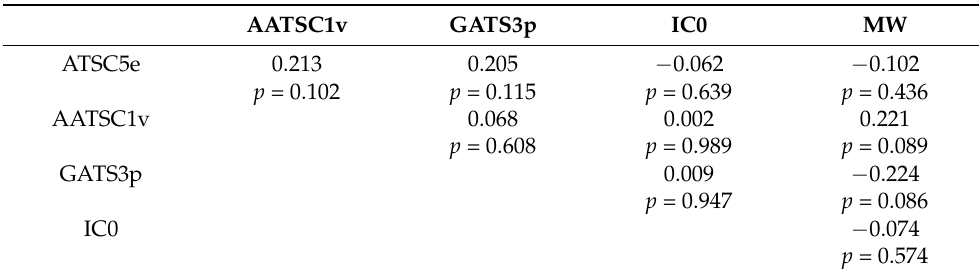
Table 5. Correlation matrix of the molecular descriptors.